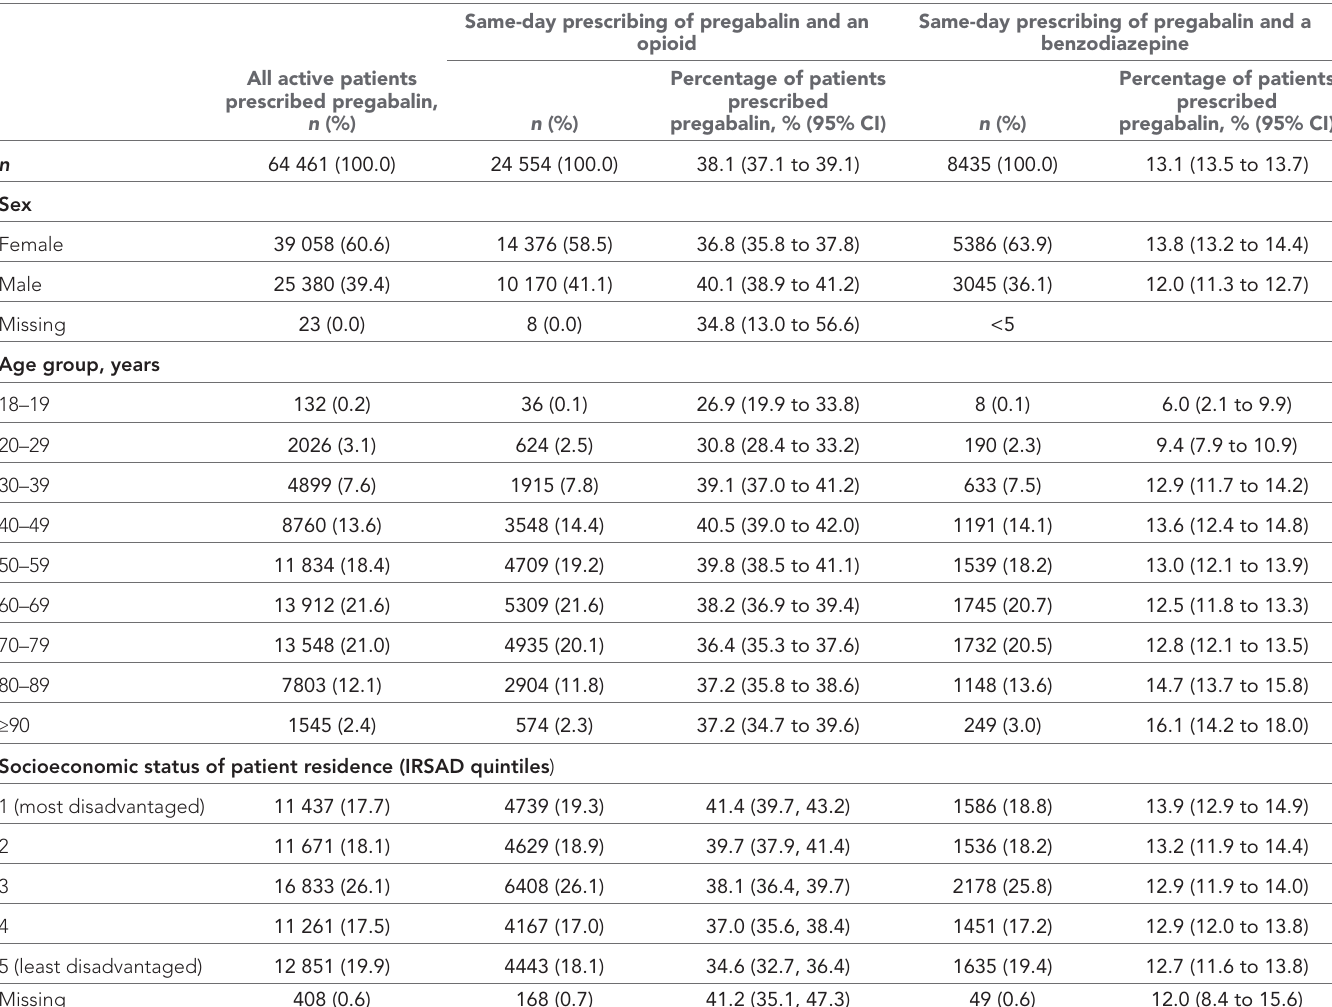
Table 3 Characteristics of people with same- day prescribing of pregabalin and an opioid or benzodiazepine among people pre- scribed pregabalin for whom capture of same- day prescribing was available, March 2012–February 2018 ( n = 64 461)